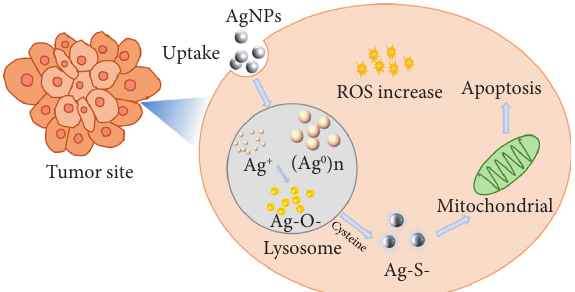
Figure 7: Mechanism of noble metal nanoparticles promoting apoptosis of tumor cells by cytotoxicity.